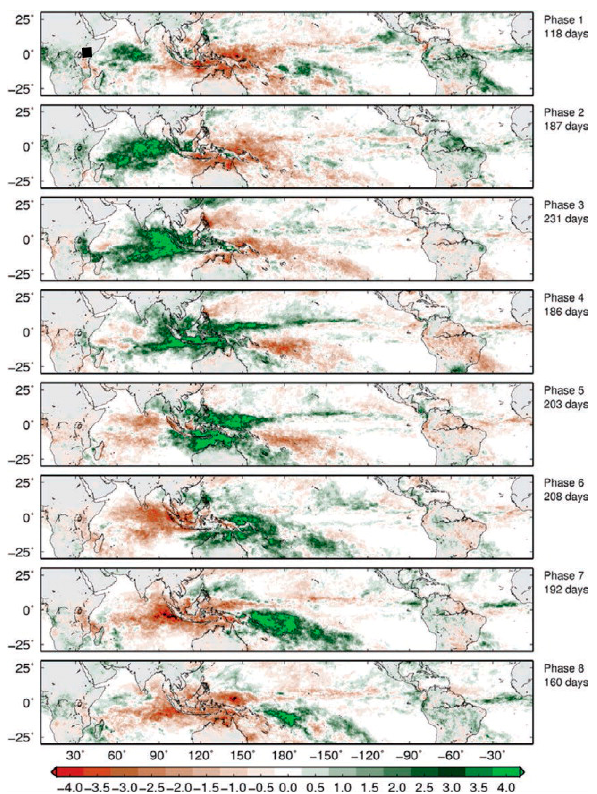
Figure 1. Composites of intra-seasonal (30–90 days) anomalies in satellite-derived (Tropical Rainfall Monitoring Mission, TRMM) precipitation (mm day − 1 ) during November–April (1998–2012) based on the Realtime Multivariate MJO (RMM) index (from Zhang [18]). The black square in the top panel indicates the approximate location of the study area.